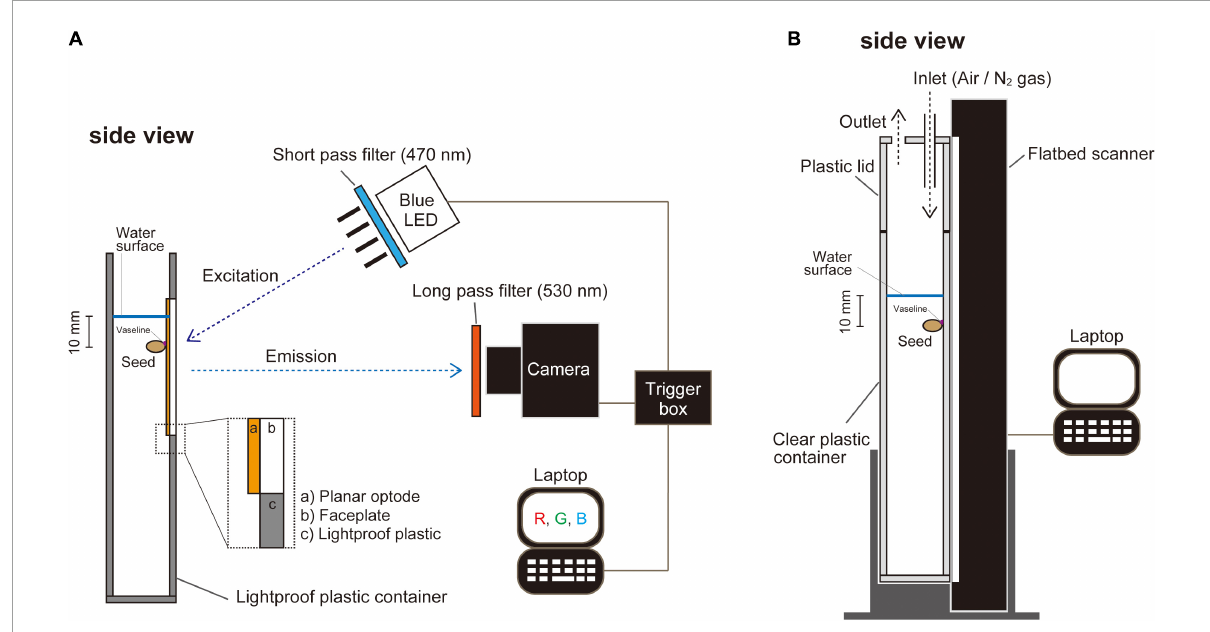
FIGURE1 A schematic representation of the plant growth container in front of a color-ratiometric planar O 2 optode system and the growth monitoring system. (A) The planar O 2 optode, which is cast on an optical and the O 2 sensitive chemistry, is excited by a blue LED ( λ -peak = 457 nm) with a 470 nm short-pass filter. Emission images are captured by a digital camera with a 530 nm long-pass filter. (B) Setup of monitoring the growth development by an automated scanning system. Images of A4 size (210 mm × 297 mm) were recorded every 20 min. Oxygen availability in the experimental setup was controlled by an influx of air (normoxic atmosphere) or N 2 gas (anoxic